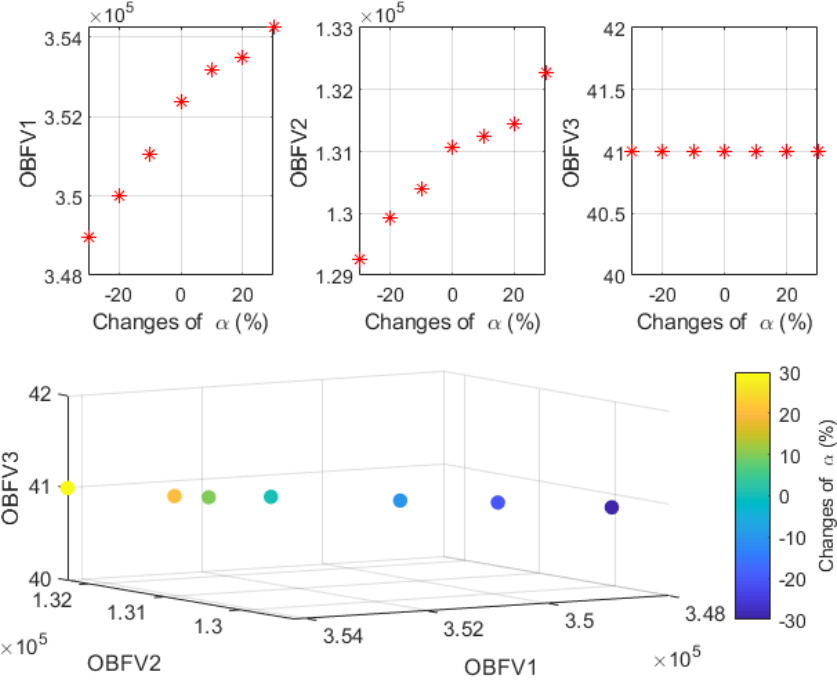
Figure 7. Trend of changes in the OBFVs in different value of parameter α . Table 9. OBFVs in changing effect of parameter α s